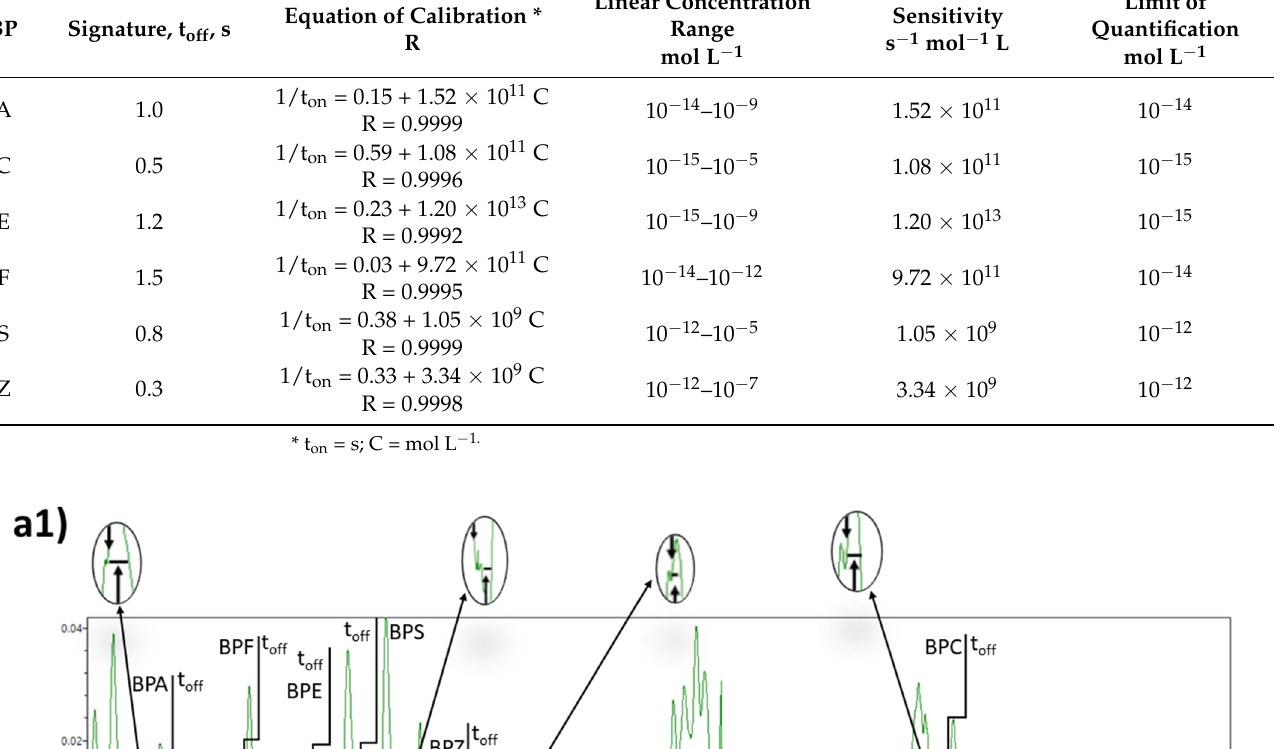
Figure 4. EDAX spectrum and the elemental composition of deposition onto the ( a ) copy paper sub- strates and ( b ) silicon wafer, respectively.